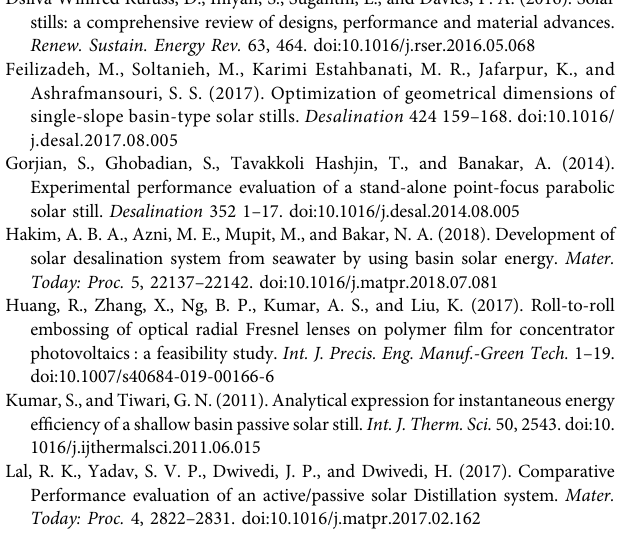
Frontiers in Energy Research |